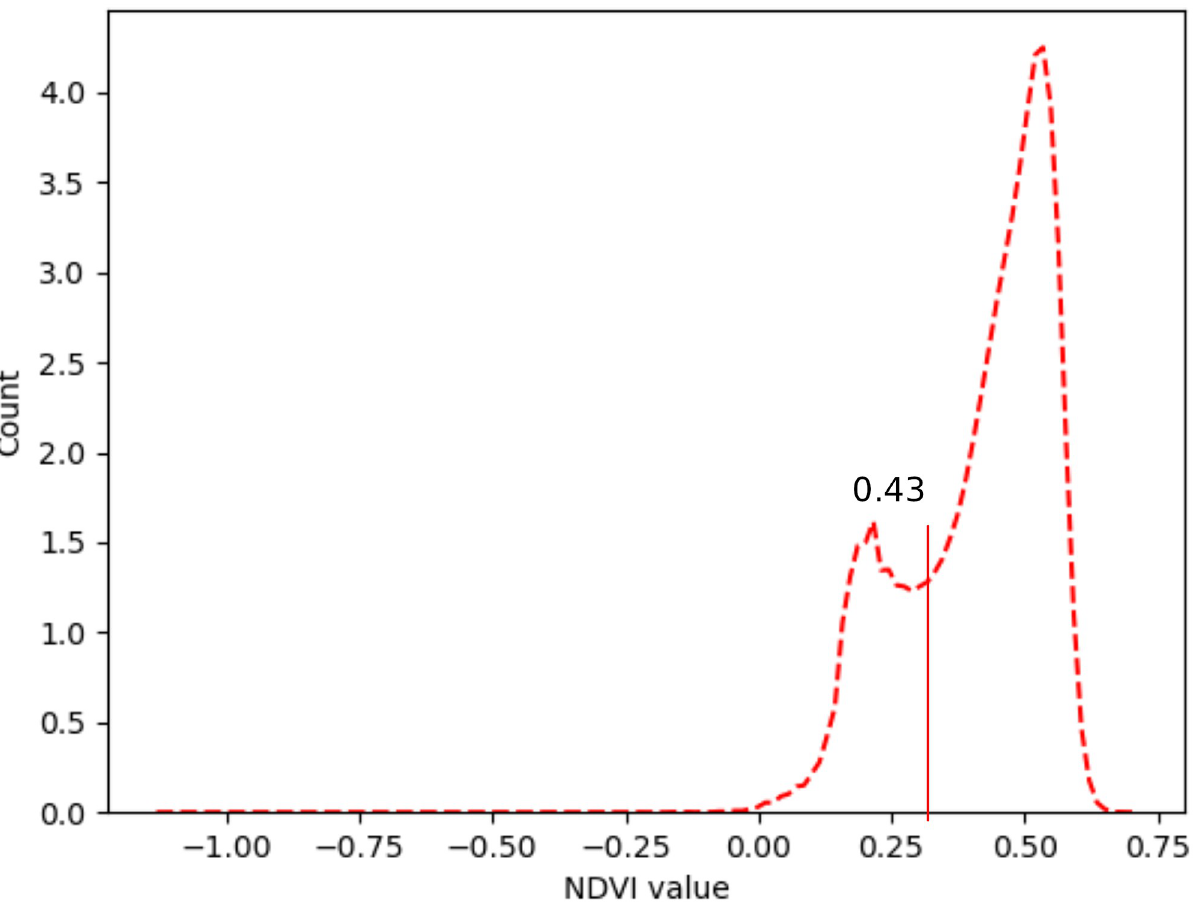
Fig 3. NDVI histogram in